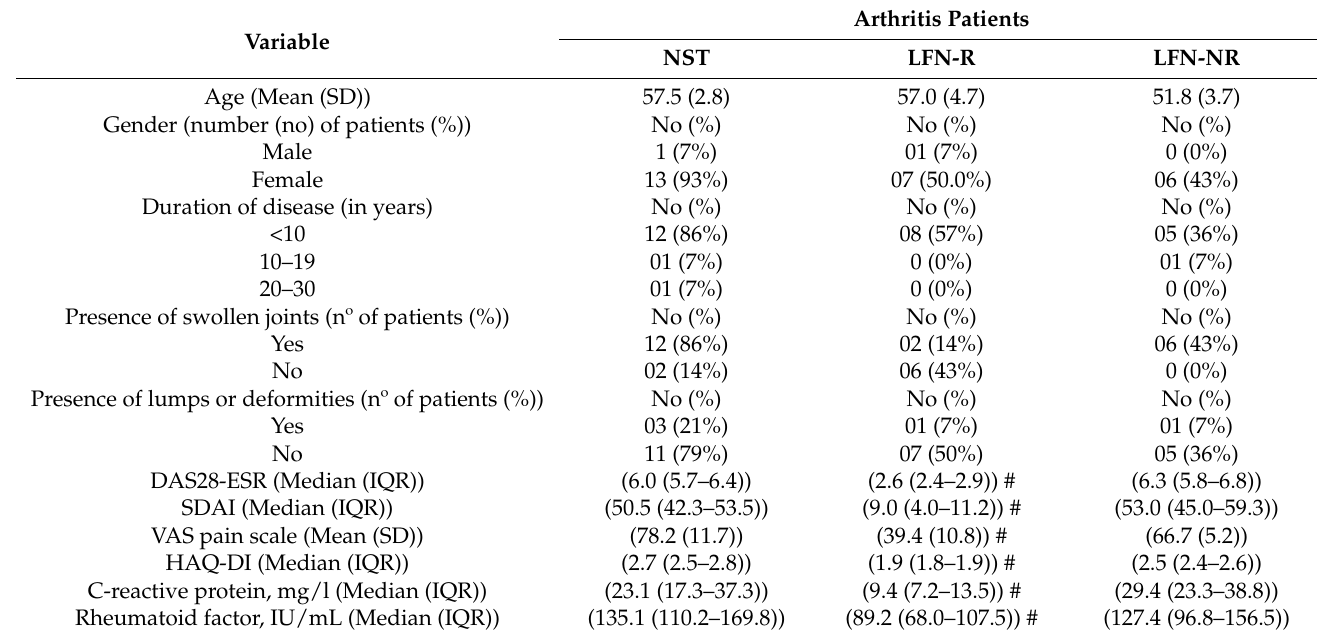
Table 1. Characteristics of the